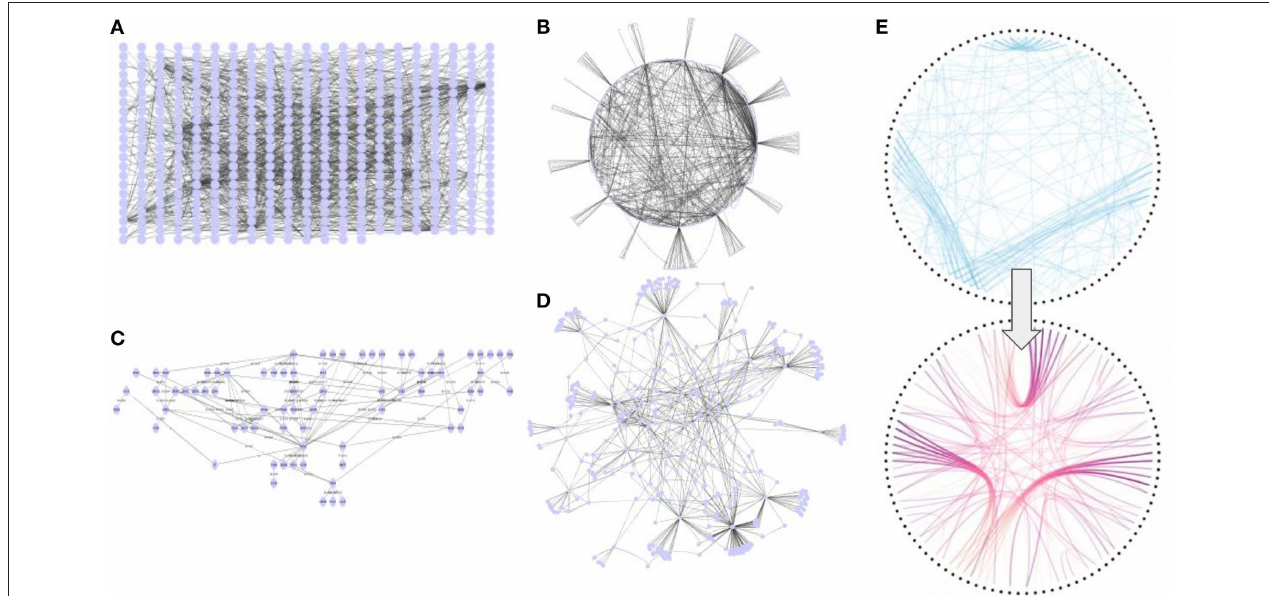
FIGURE 8 | Network layouts. (A) Grid layout. (B) Circular layout. (C) Hierarchical layout. (D) Force-directed layout (E) Edge-bundling. All views have been generated with